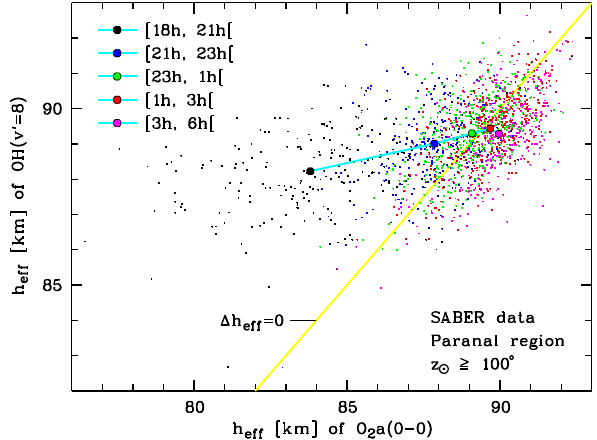
Figure 10. Comparison of effective emission heights h eff in km for OH( v (cid:48) = 8) and O 2 a (0-0) for the Cerro Paranal SABER sample. The mean values for five different nighttime LT periods are shown by big circles of different colours connected by lines (see legend). The colours of the individual data points correspond to those of the related mean